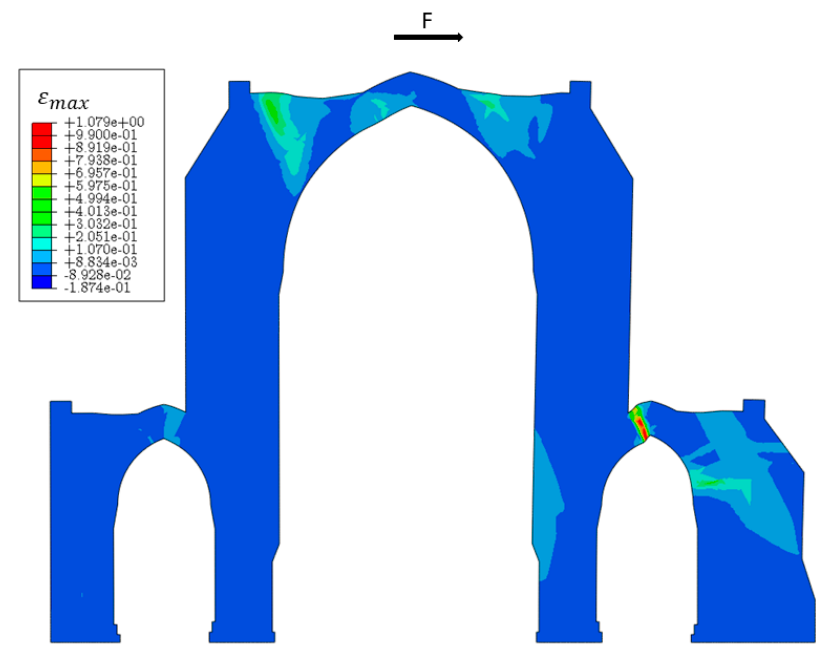
Figure 12. T macro-element: distribution of the maximum plastic